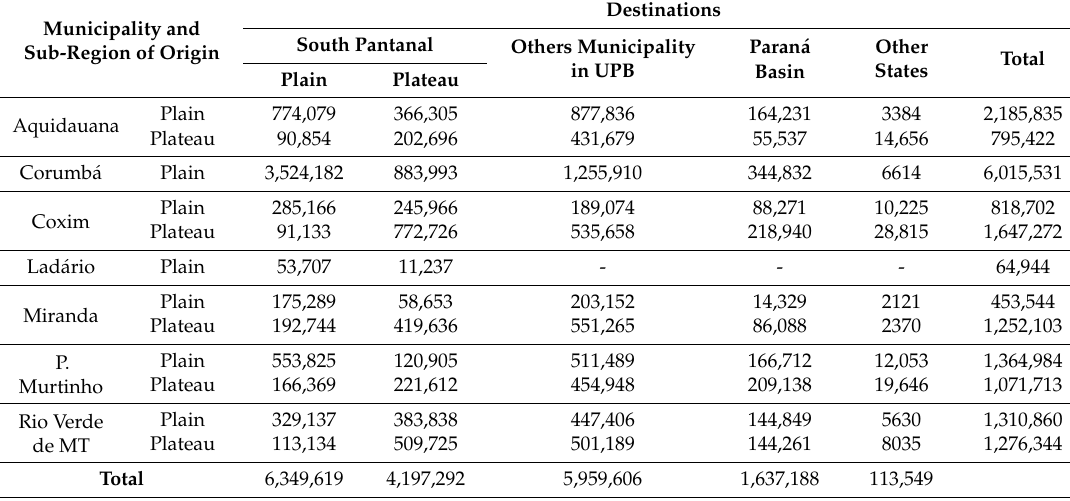
South Pantanal Others Municipality